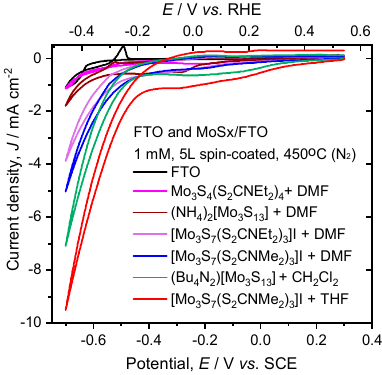
Figure 2. Polarization curves of MoS 2 /FTO electrodes fabricated at 450 °C in a nitrogen environment. Scan rate: 50 mV s –1 ; electrolyte: 0.5 M H 2 SO 4 . Reproduced with permission from [24], published by Royal Society of Chemistry,